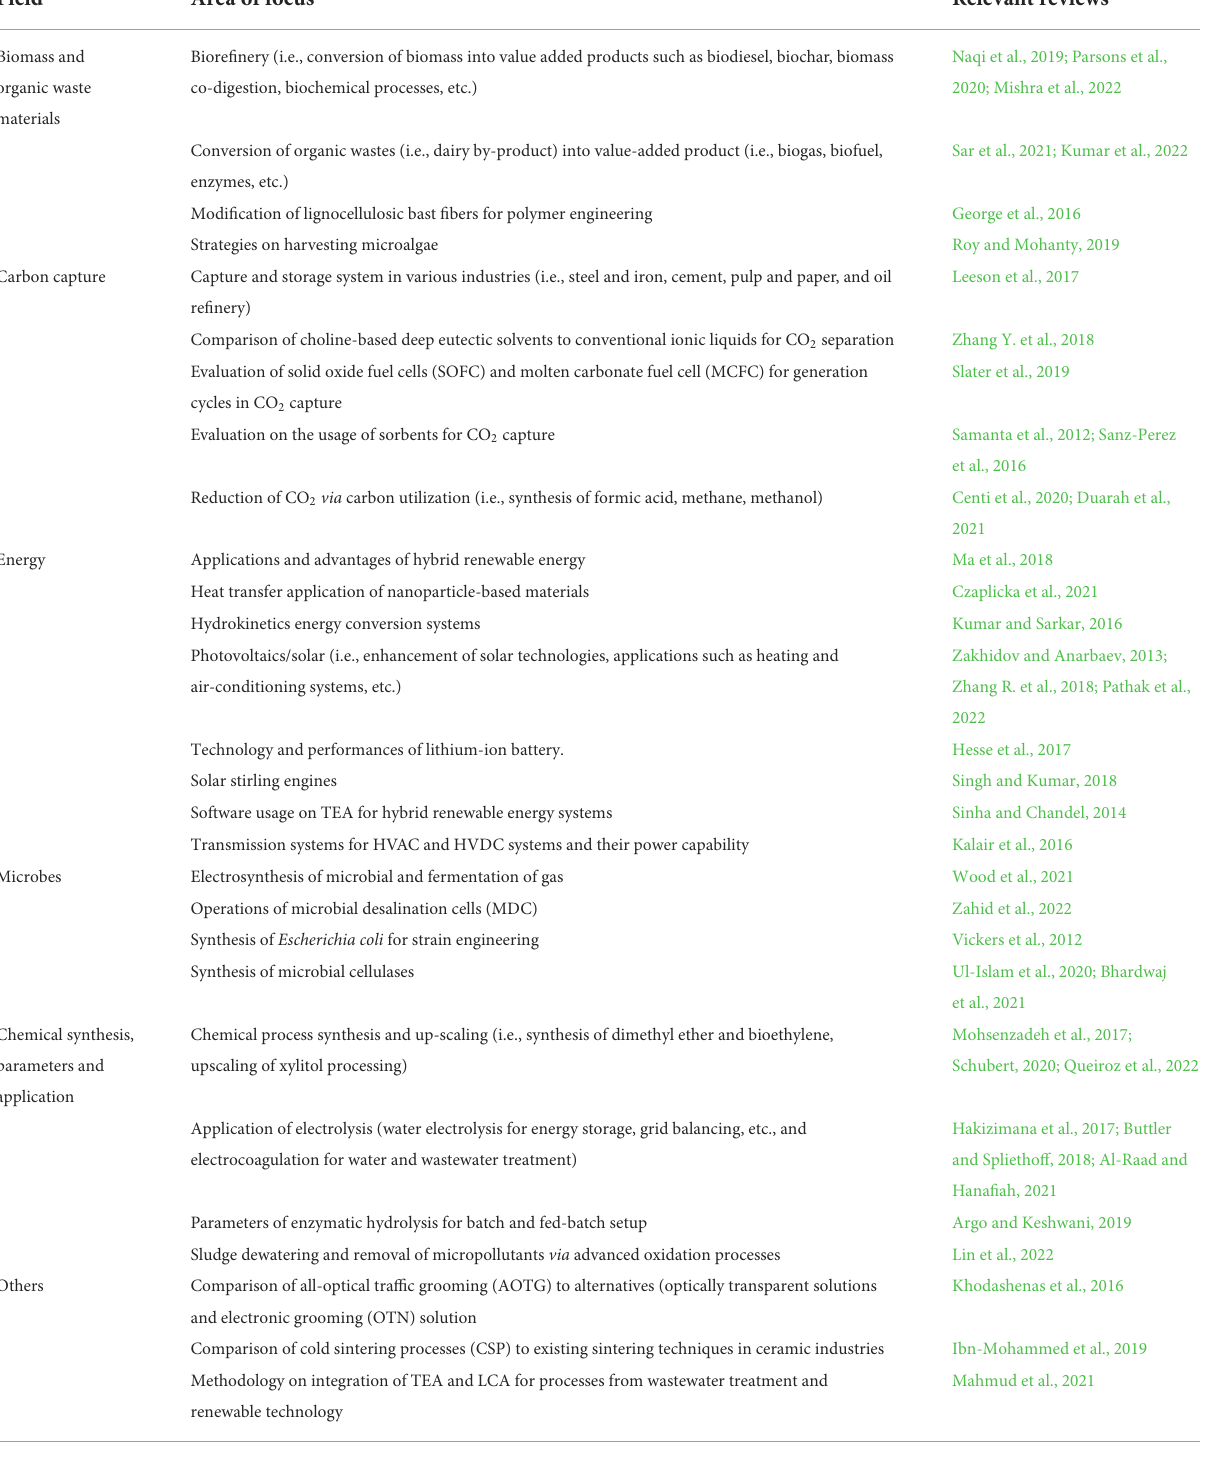
TABLE 1 Compilation of relevant reviews with TEA analyses conducted for past two decades (2002 to